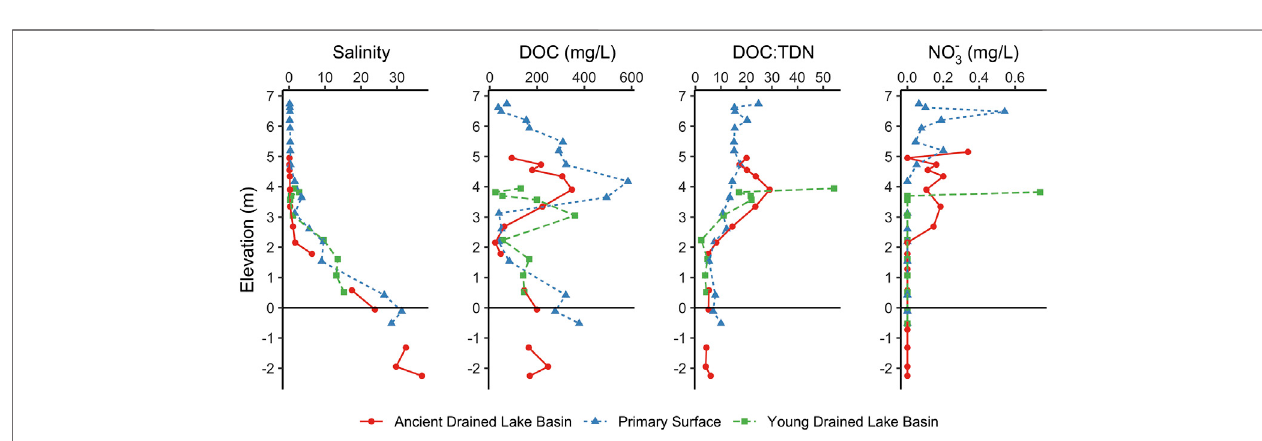
FIGURE6| Porewater salinity,dissolved organiccarbon (DOC;mg C L − 1 ),dissolved organic carbon tototal dissolved nitrogen molar ratio(DOC:TDN),and nitrate (NO 3 − ;mg NO 3 − L − 1 ) pro fi les for threepermafrost cores.Colorsand symbolsindicate the geomorphic terrain unit each core wassampled from. Theblack horizontal line indicates mean local sea level.